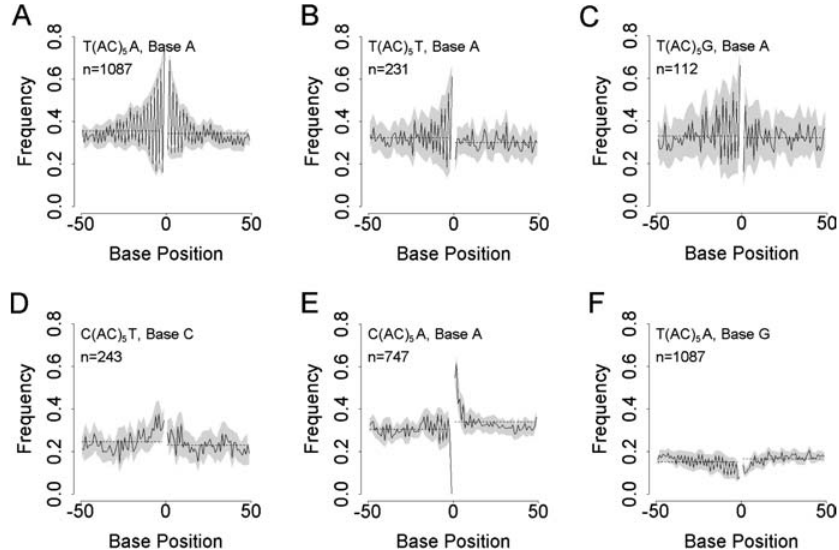
Figure 3. Flanking Sequence Frequency Distributions for Six Representative Nu- cleotide–Cassette Combinations for (AC) 5 Microsatellites In each panel, the microsatellite is centrally placed, represented as a gap at position zero, and the cassette type, base, and number of sequences consid- ered (n) are given. Frequency distribu- tions are plotted with separate 95% confidence intervals for odd- and even- numbered positions (shading). Horizon- tal lines indicate mean frequencies for the 3 9 and 5 9 flanking regions, calculated separately. (A–F) illustrate the six main classes of patterning where either dinu- cleotide periodicity or 5 9 –3 9 asymmetry are present, summarised for all cassette– base combinations in Table 1. DOI: